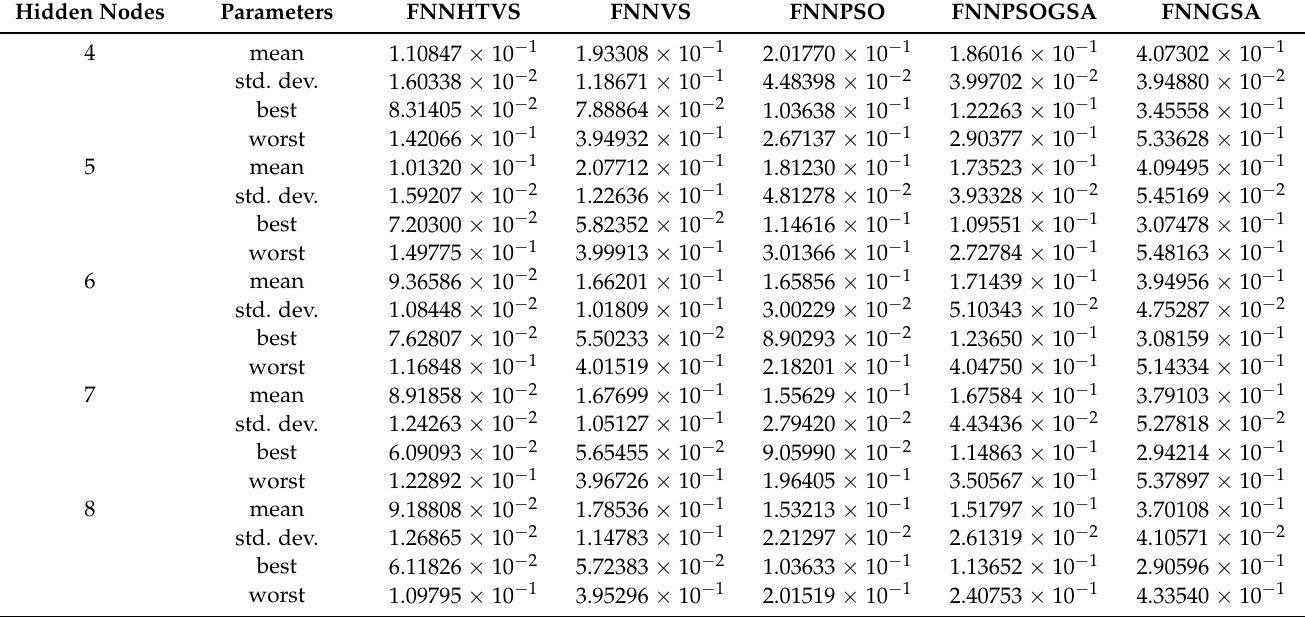
Table A4. Statistical results (MSE) in the seed classification